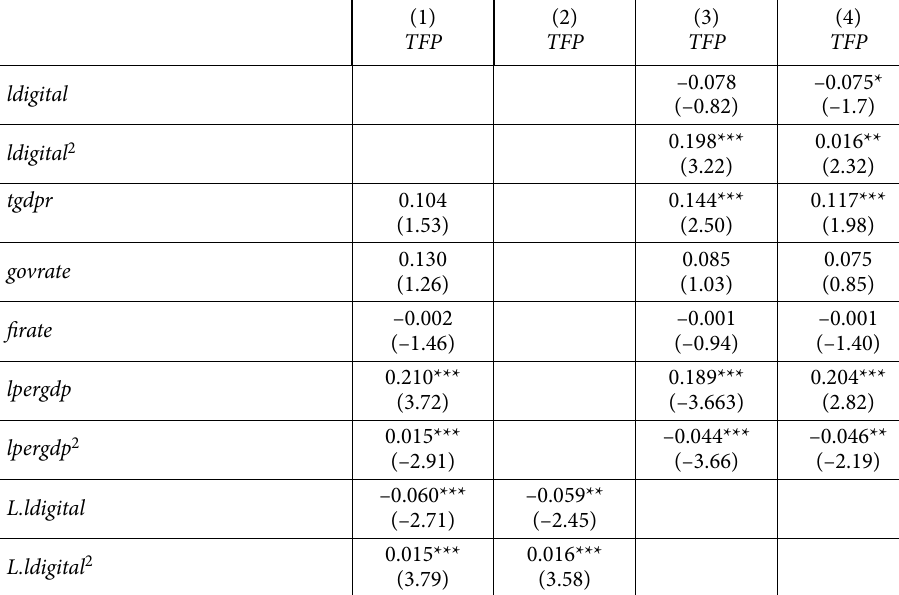
Table 7. Endogeneity and robustness